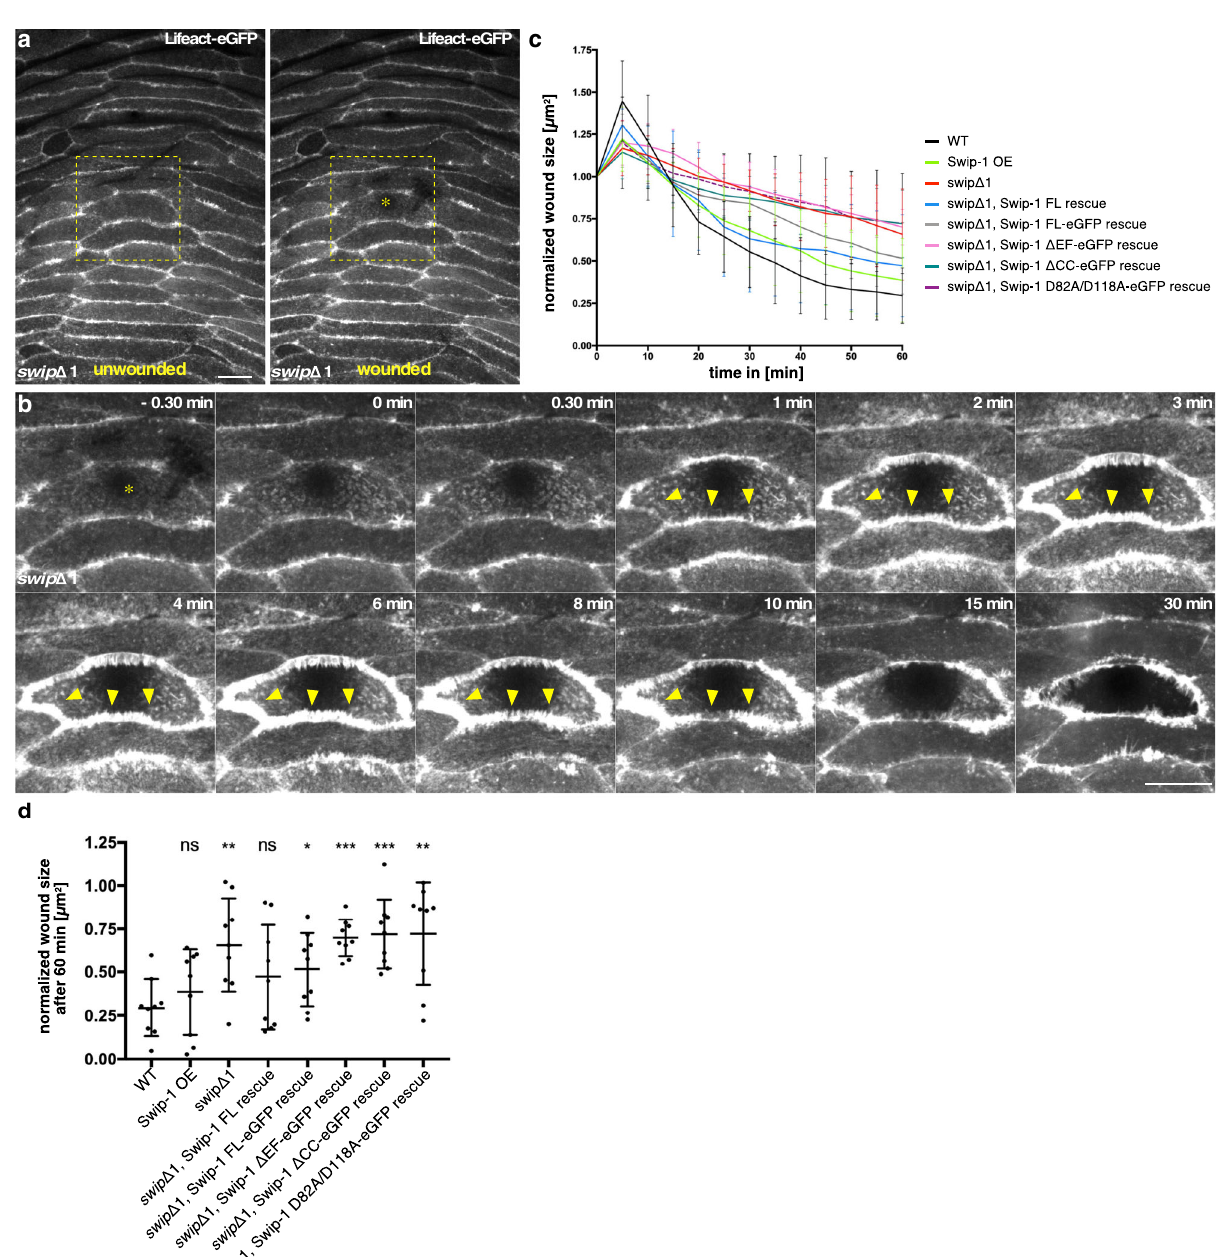
Fig. 5 Epithelial wound closure requires Swip-1 function. a Single-cell ablation in the abdominal epidermis of a swip-1 mutant 18 h APF old pupa ubiquitously expressing a Lifeact-eGFP transgene under the control of the da -Gal4 driver. Images were taken every 30 s for 60 min, ablation starts at t = 0 min. Overview of the imaged area, an asterisk indicates the position of cell ablation. Scale bar 25 µ m. The image is representative of nine independent experiments. b Magni fi cation of ablated cell shown in a at the indicated times, arrows indicate irregular unstable lamellipodial protrusions at the wound margin. Scale bar 25 µ m. c Quanti fi cation of wound closure in wild type (WT), swip-1 mutant (swip Δ 1), after overexpression (Swip-1 OE) and rescue by re- expressing distinct Swip-1 transgenes, FL: full-length; Δ EF: lacks the EF hands and Δ CC: lacks the coiled-coil region. Wound size was measured every 5 min and normalized to the initial size of the unwounded cell. d Excerpt of data from c . After 60 min, wound closure was assessed by comparing the remaining wound size normalized to unwounded cell size to wild type. Each point represents one experiment. P values: Swip-1 OE: 0.387, swip Δ 1: 0.008, swip Δ 1, Swip-1 FL rescue: 0.340, swip Δ 1, Swip-1 FL-eGFP rescue: 0.040, swip Δ 1, Swip-1- Δ EF-eGFP rescue: <0.001, swip Δ 1, Swip-1- Δ CC-eGFP rescue: <0.001, swip Δ 1, Swip-1-D82A/D118A-eGFP rescue: 0.006. c , d Bars represent the mean ± SD of nine independent experiments for each genotype. Two-sided Mann – Whitney test was used to compare each genotype individually to WT, P values: 0.12 (ns), 0.033 (*), 0.002 (**), <0.001 (***).